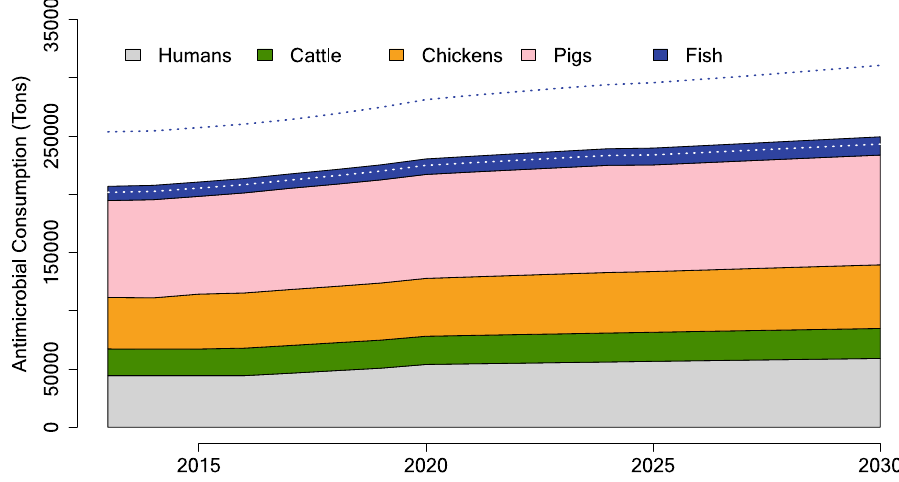
Figure 3. Global antimicrobial consumption, 2013–2030. Dotted lines represent the 95% uncertainty interval for